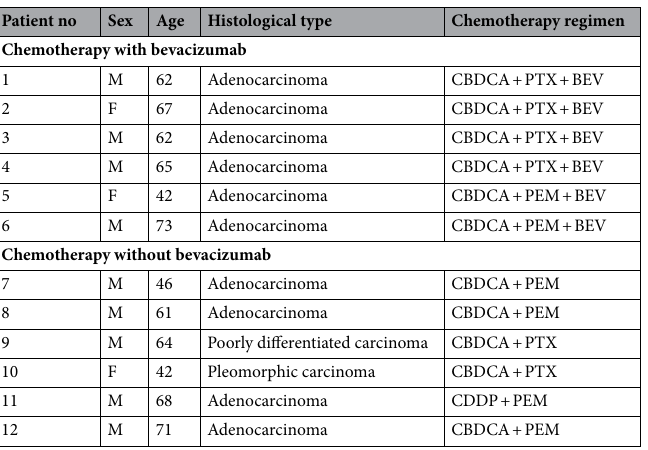
Table 1. Patient characteristics. M male; F female; CBDCA carboplatin; PTX paclitaxel; BEV bevacizumab; PEM , pemetrexed; CDDP ,